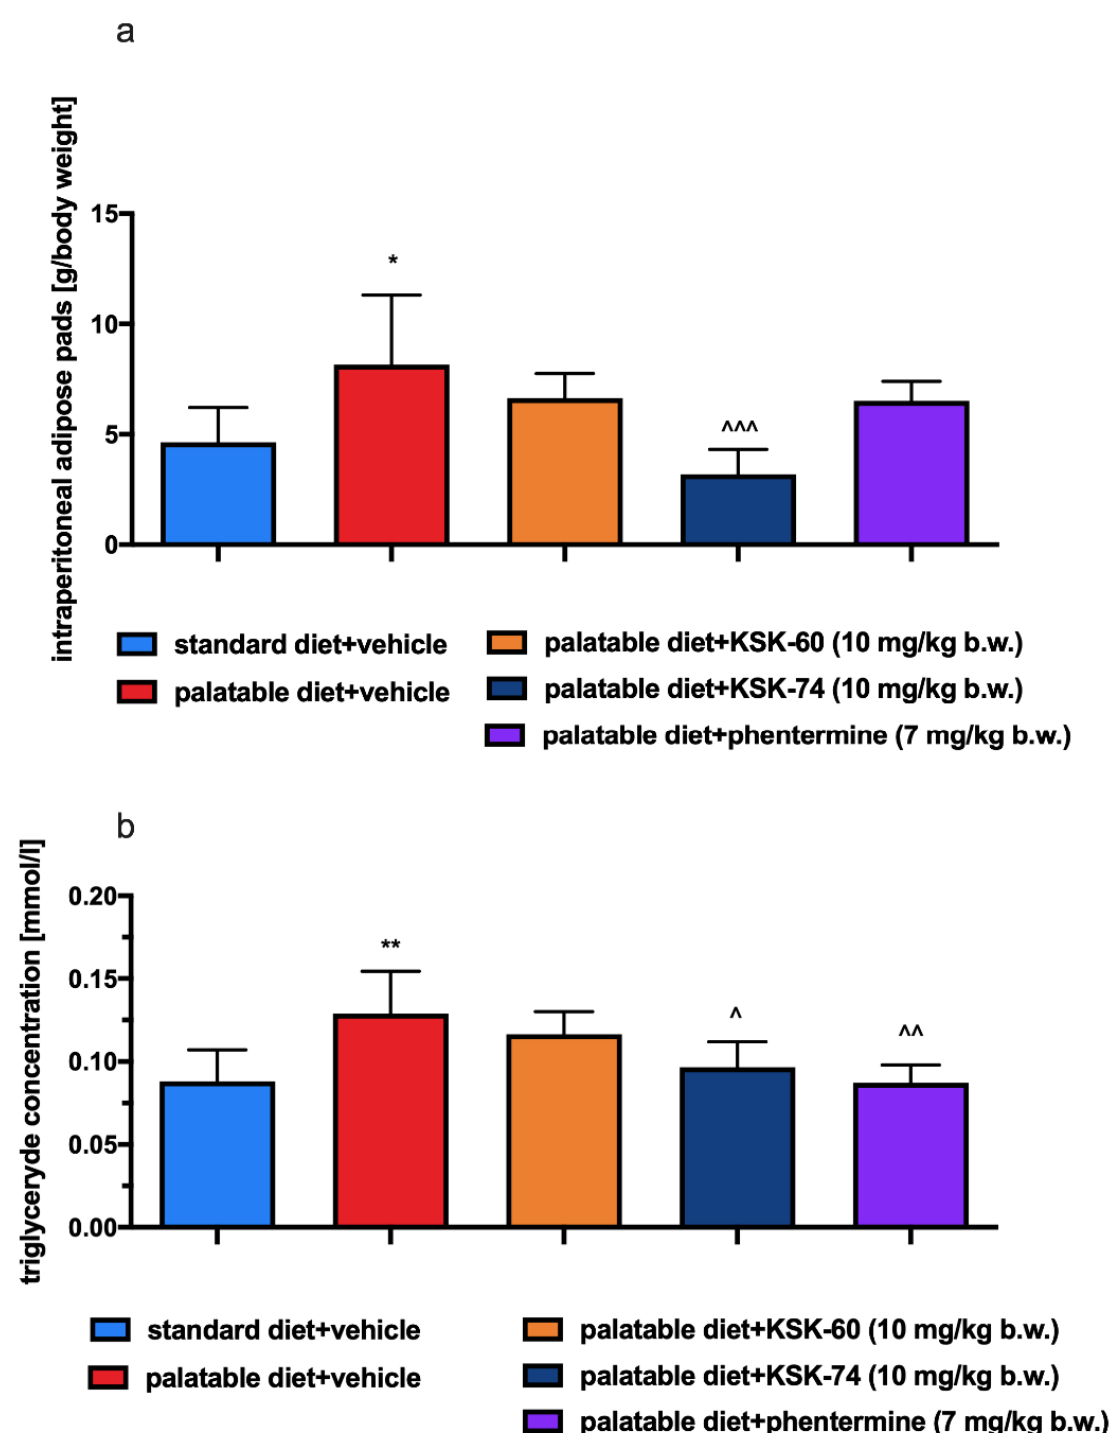
Figure 6. Mass of adipose pads at the end of the experiment ( a ), effect of the tested compounds or phentermine on the plasma level of triglyceride ( b ). Results are expressed as means ± SD, n = 6. Comparisons were made using one-way ANOVA, Tukey’s post hoc tests. * vs. standard diet + vehicle group; ^ vs. palatable diet + vehicle group; ^, * p < 0.05, ^^, ** p < 0.01, ^^^ p < 0.001.